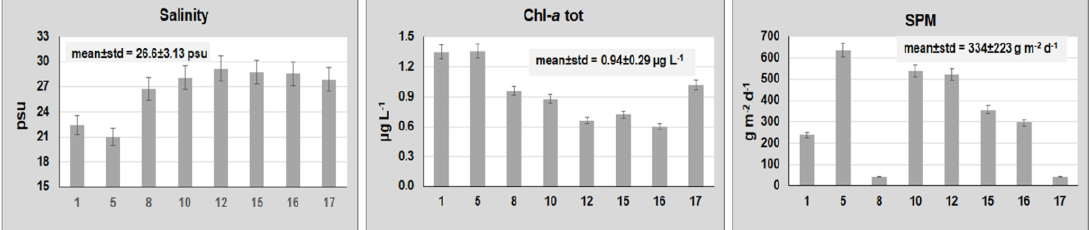
Figure 7. Values of salinity, total chlorophyll- a (Chl- a tot), and settled particulate matter (SPM) collected by sedimentation traps).